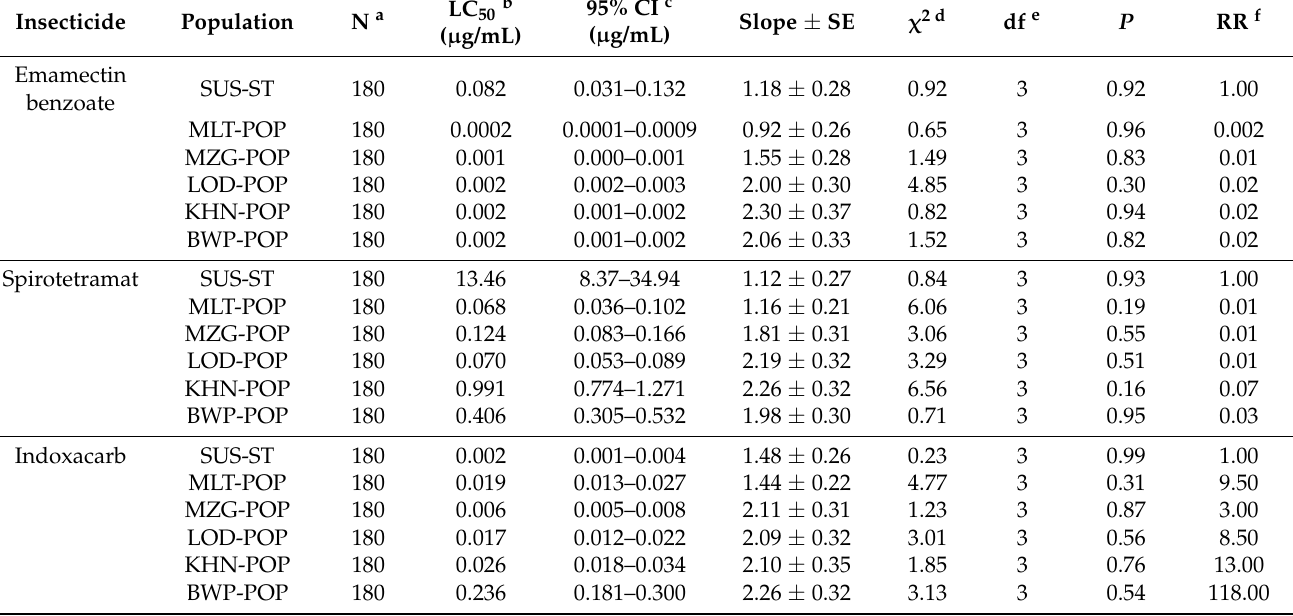
Table 3. Resistance levels of Culex quinquefasciatus to emamectin benzoate, spirotetramat, and